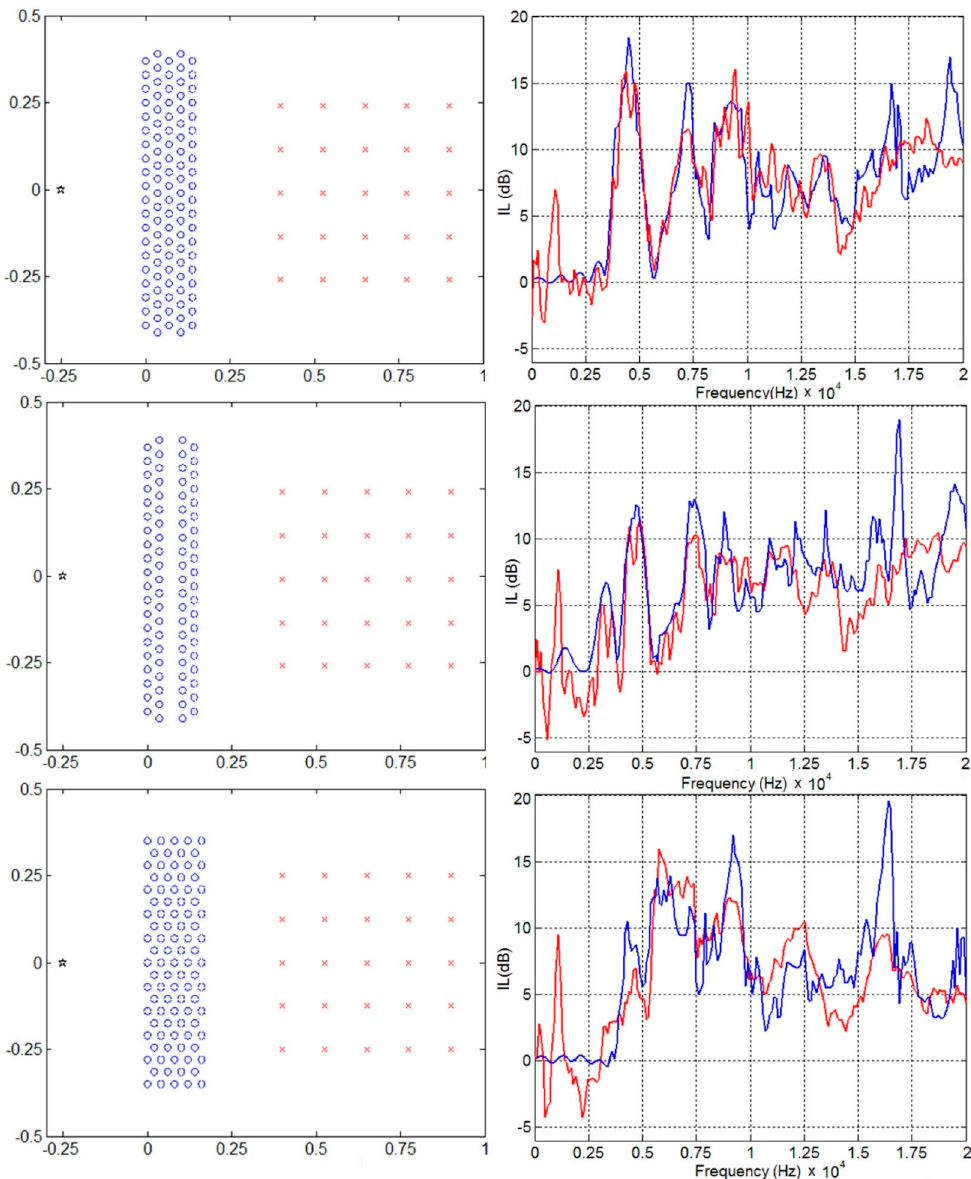
Figure 7. Rows of scatterers or random scatterers repositioned from triangular lattice, modified from [51].